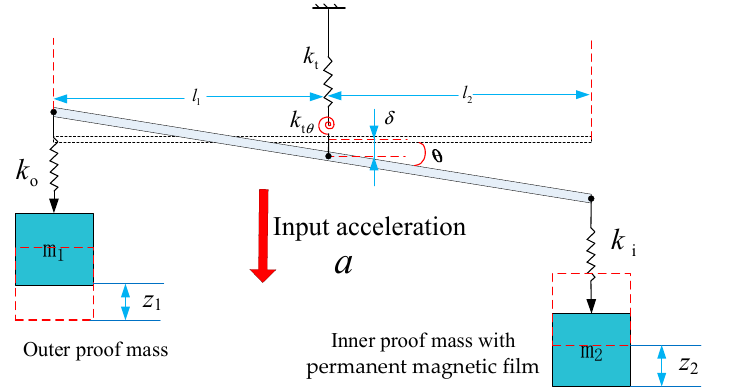
Figure 2. Simplified structural model.